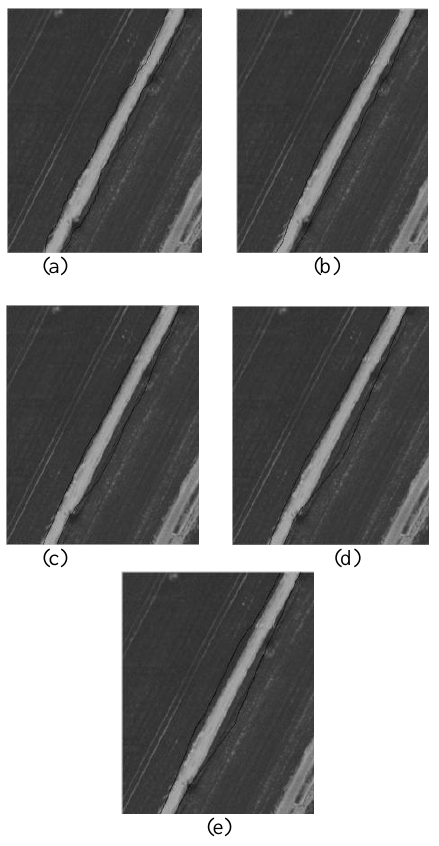
Figure 10: (a)Ziplock Snake (10x10) Gaussian Kernel Filter (b)Ziplock Snake (20x20) Gaussian Kernel Filter (c)Ziplock Snake (30x30) Gaussian Kernel Filter (d)Ziplock Snake (40x40) Gaussian Kernel Filter (e)Ziplock Snake (50x50) Gaussian Kernel Filter